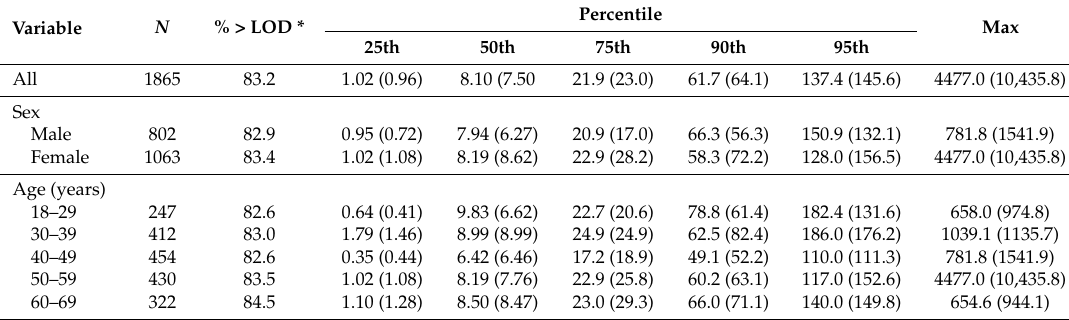
Table 2. Selected urine concentration percentiles of 4-nonylphenol in the Korean population aged 18–69 years, by sex and age